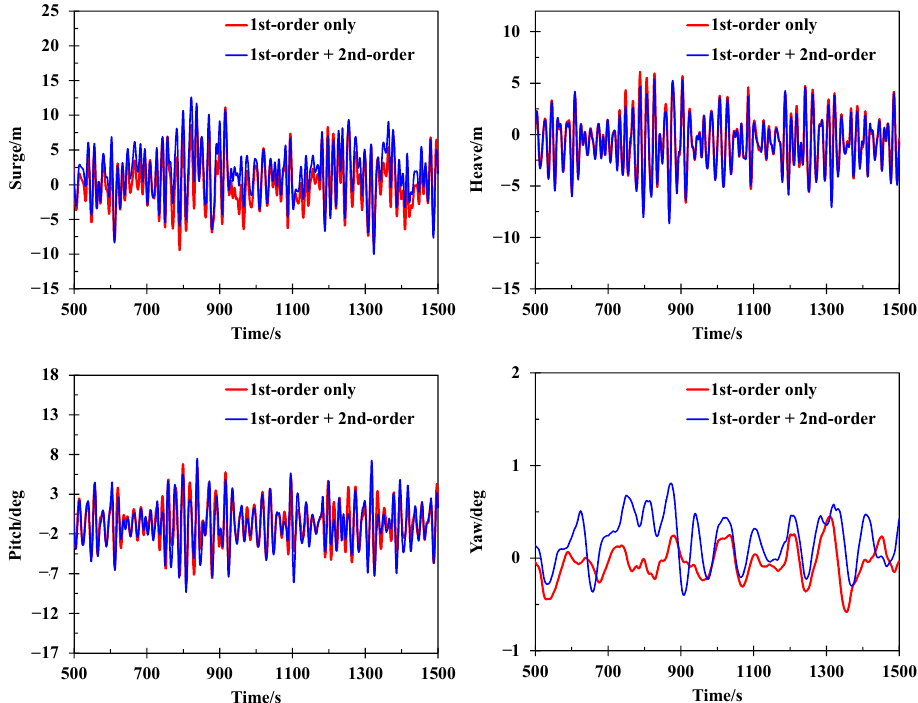
Figure 7. Time-varying platform motions under the extreme condition with and without considering the second-order wave excitations.